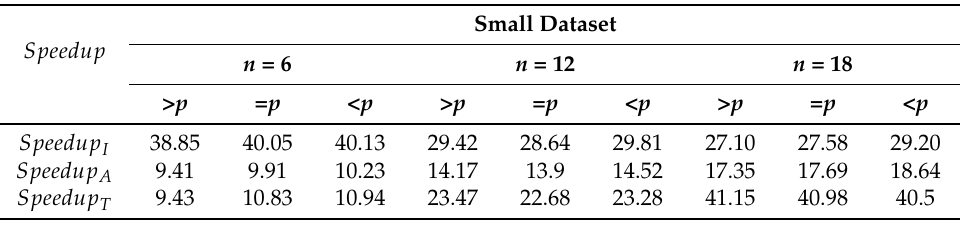
Table 3. Speedup obtained with a single card on Shelob (small dataset).